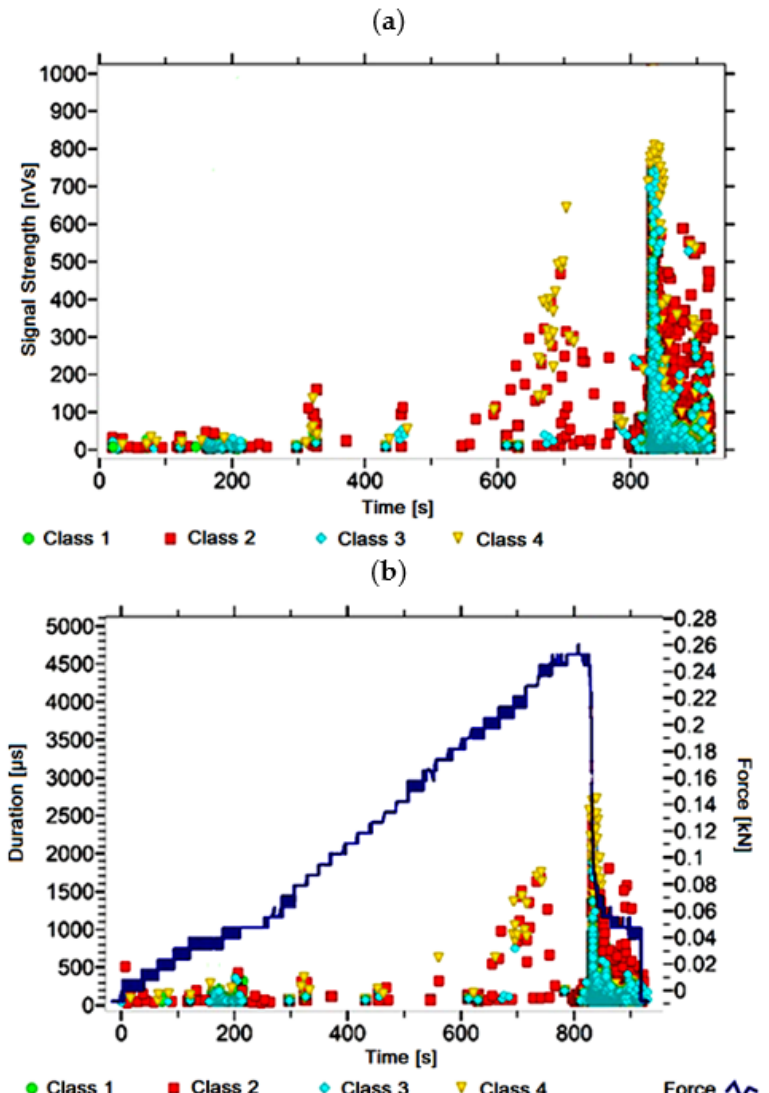
Figure 6. Graphs of acoustic emission signals for an exemplary sample of A 5 series: ( a ) signal strength over time; ( b ) distribution of the duration of the signals over time with the force increment